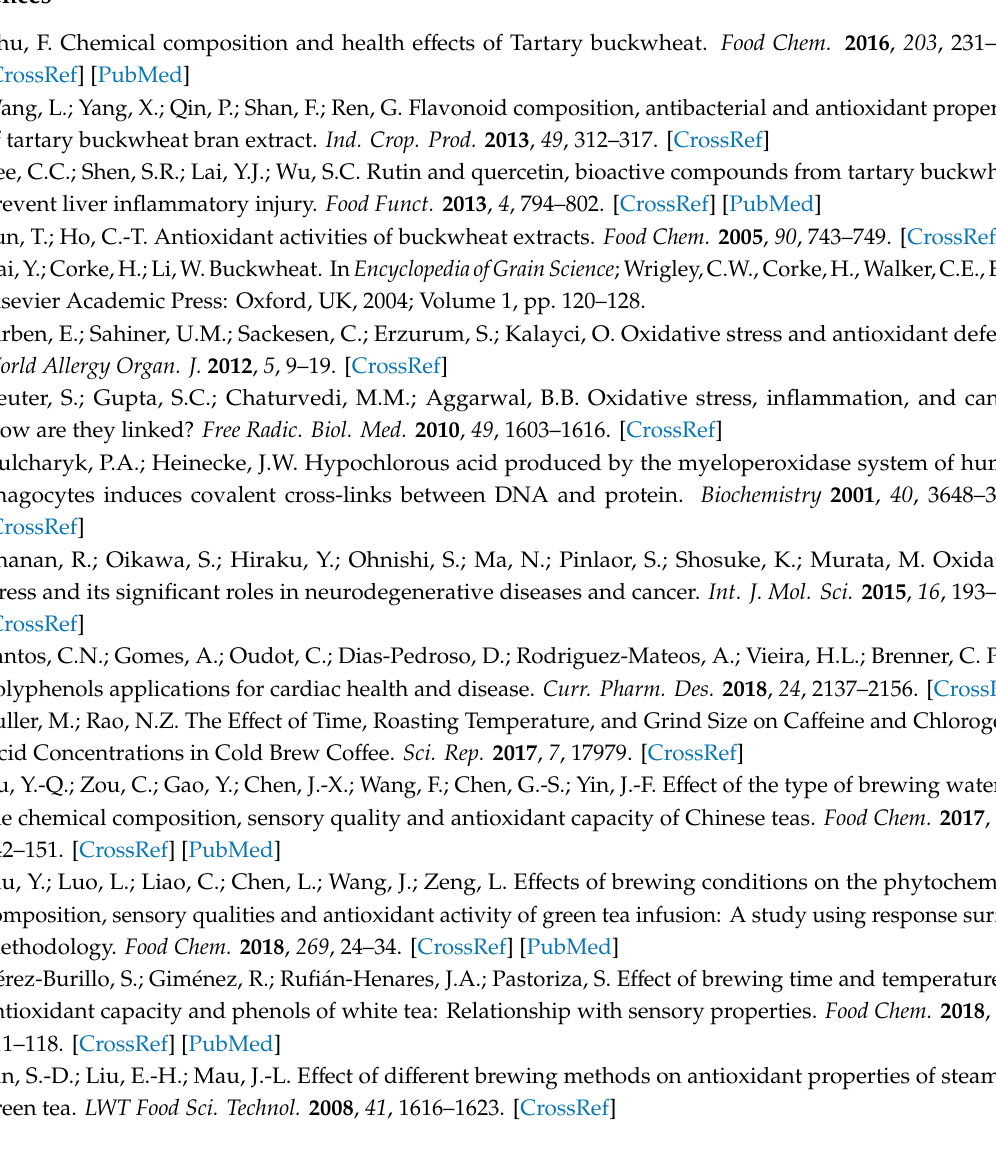
Figure S1: HPLC chromatograms of TB